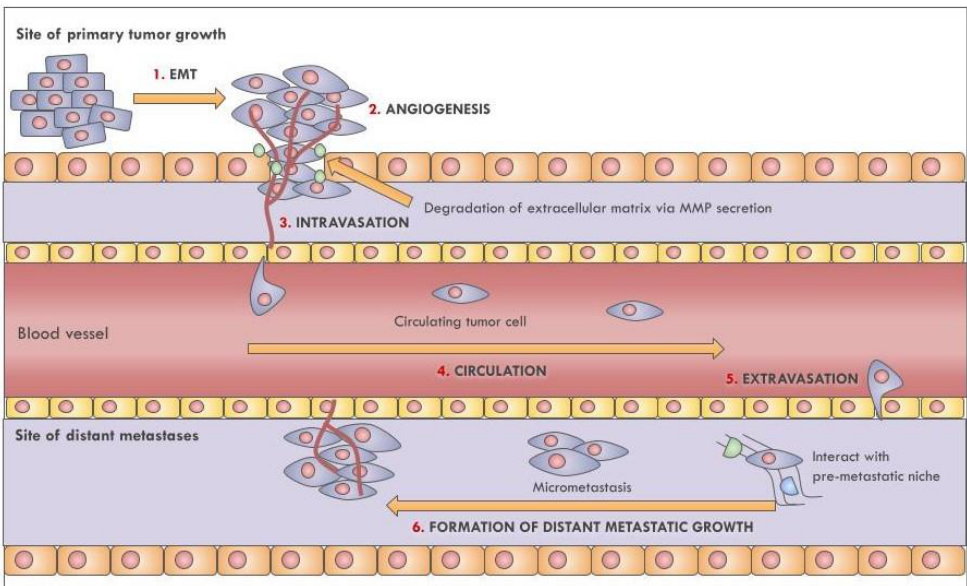
Figure 1. Principle phases of the metastatic process. The first step of a metastatic event involves a phenotypical transformation, specifically epithelial-to-mesenchymal transition of tumor cells (EMT); this allows for tumor invasion into surrounding connective tissue. The hypoxic conditions of the tumor microenvironment will induce tumor cells to secrete angiogenetic factors, which promote the formation of new vessels for reaching nutrients (angiogenesis), and intravasation or entry into circulation. The circulating tumor cells will travel through the turbulent circulatory system until they arrive at distant organs; here, the cells interact with pre-formed pre-metastatic niches to form new cancerous growths. Eventually, these tumors can disseminate and form further distant metastases.